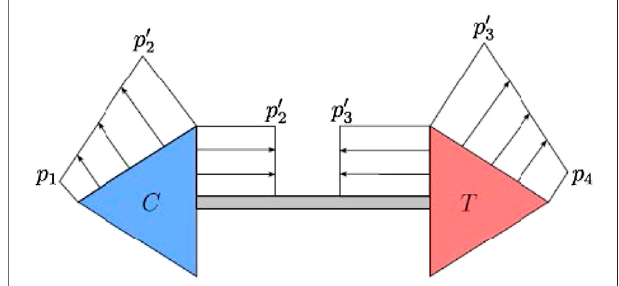
FIGURE 24 | Schematic pressure distribution at the compressor and turbine wheels, Serrano et al.